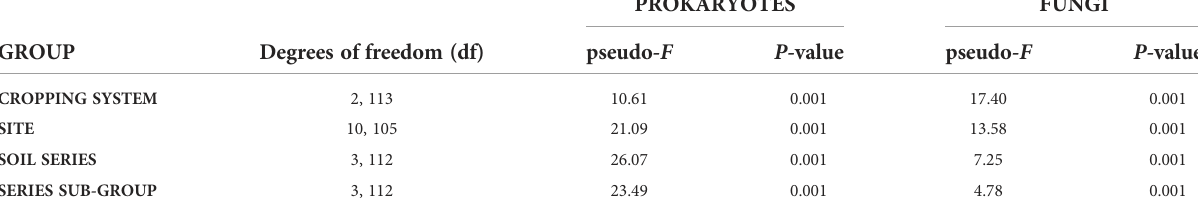
TABLE 2 One-way PERMANOVA of UNIFRAC responses according to the cropping system and soil classi fi cations of the sites.